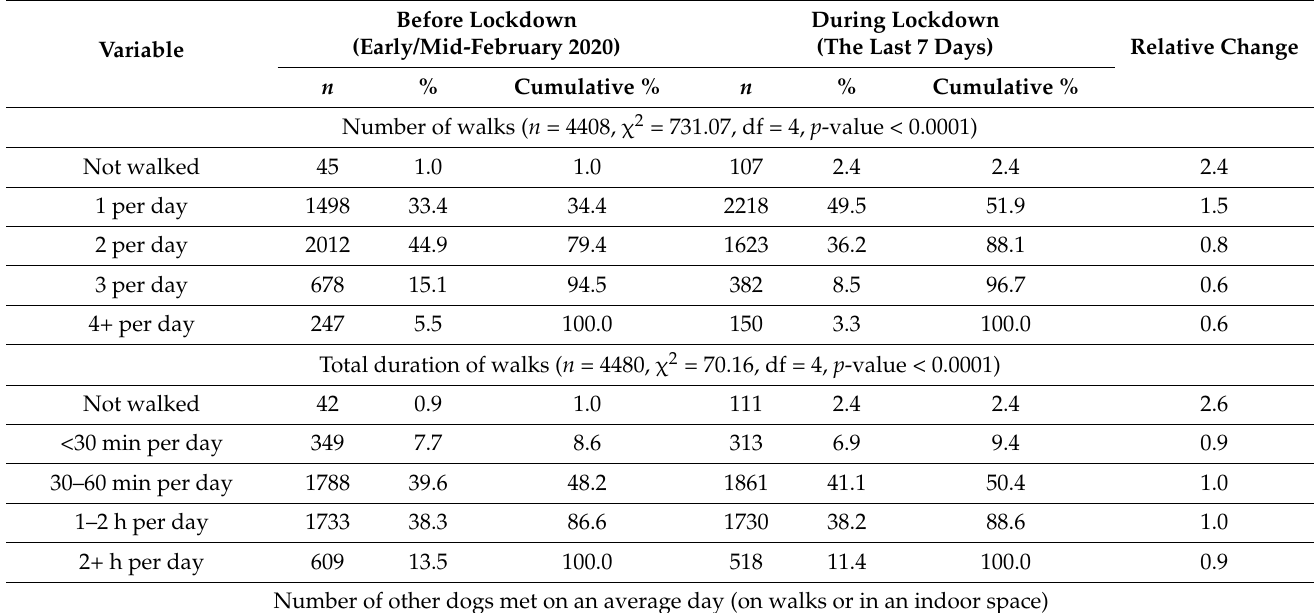
Table 3. Daily walk frequency and total walk duration before and during lockdown period, and number of other dogs met (on walks or in an indoor space) during each